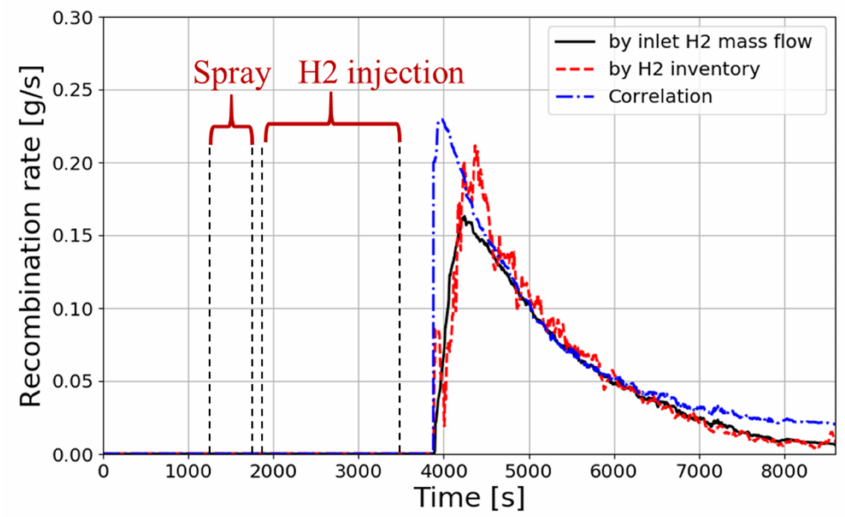
Figure 18. Comparison of the hydrogen recombination rates for the SSP3 test.